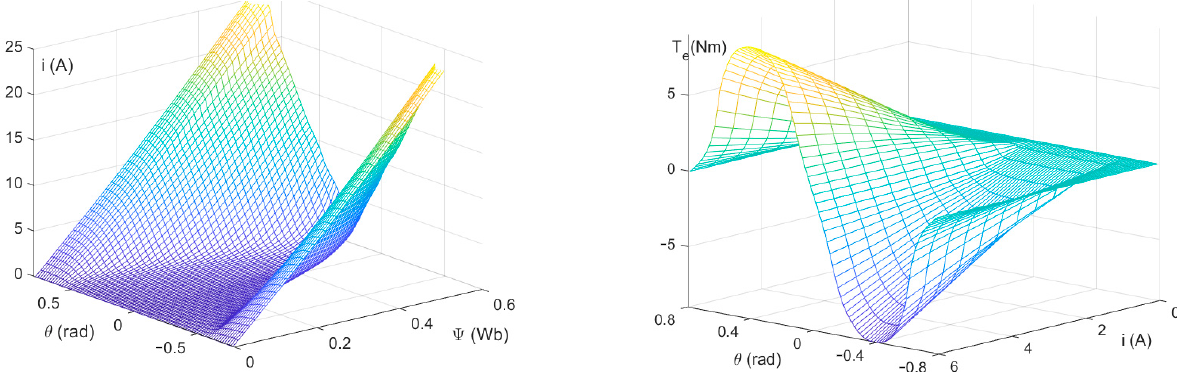
Figure 2. The dependences of the phase current i on the magnetic flux Ψ and the rotor position angle θ , and the motor electromagnetic torque T e on the phase current i and the rotor position angle θ .